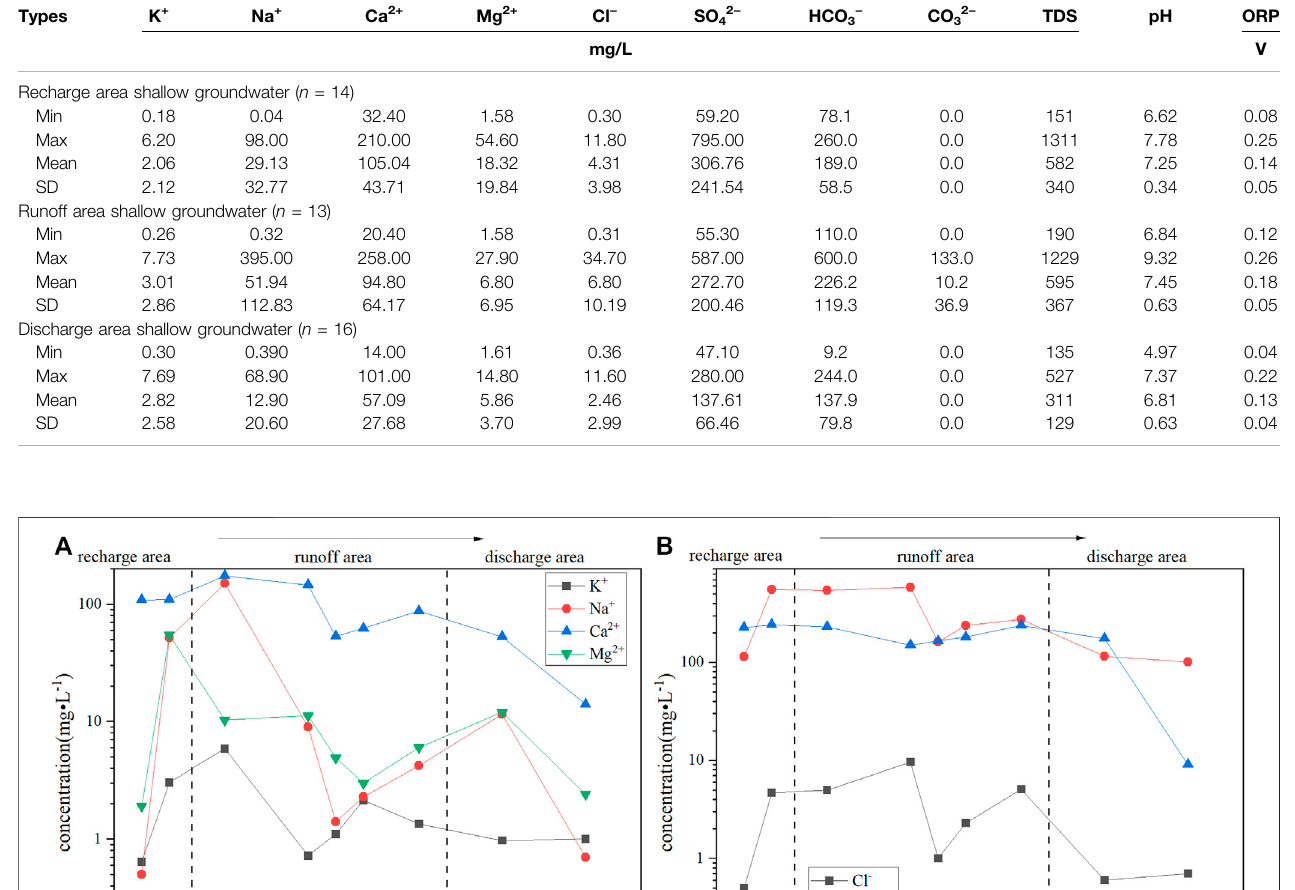
TABLE 1 | Geochemical data of samples collected in this study.